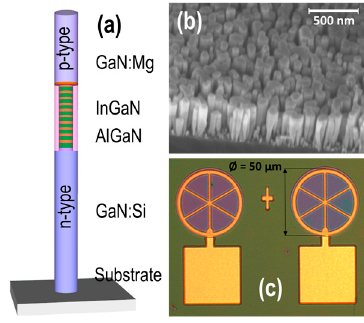
Figure 1. Schematic structure of a nanowire micro light-emitting diodes ( μ LED) with ten InGaN/AlGaN quantum well heterostructures ( a ); the 45 ° tilted SEM image of InGaN/AlGaN nanowires on Si substrate ( b ); and optical image of μ LEDs and the electrode pads ( c ).